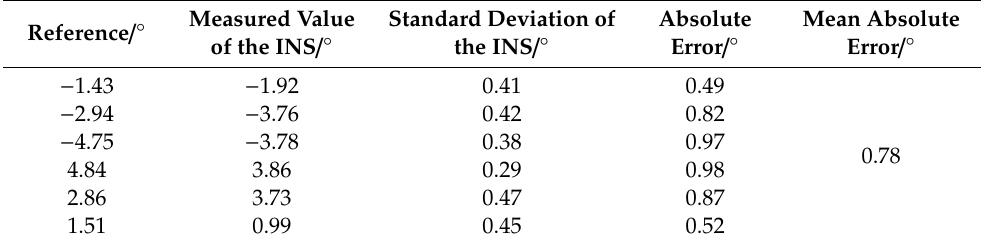
Table 1. Data from the INS.